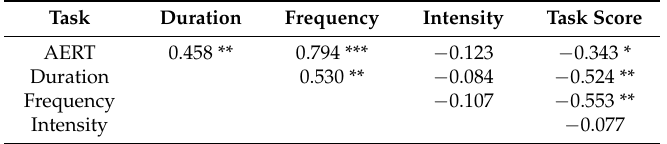
Table 6. Correlation coefficients (Pearson one-tailed) for AT tasks and accuracy score.